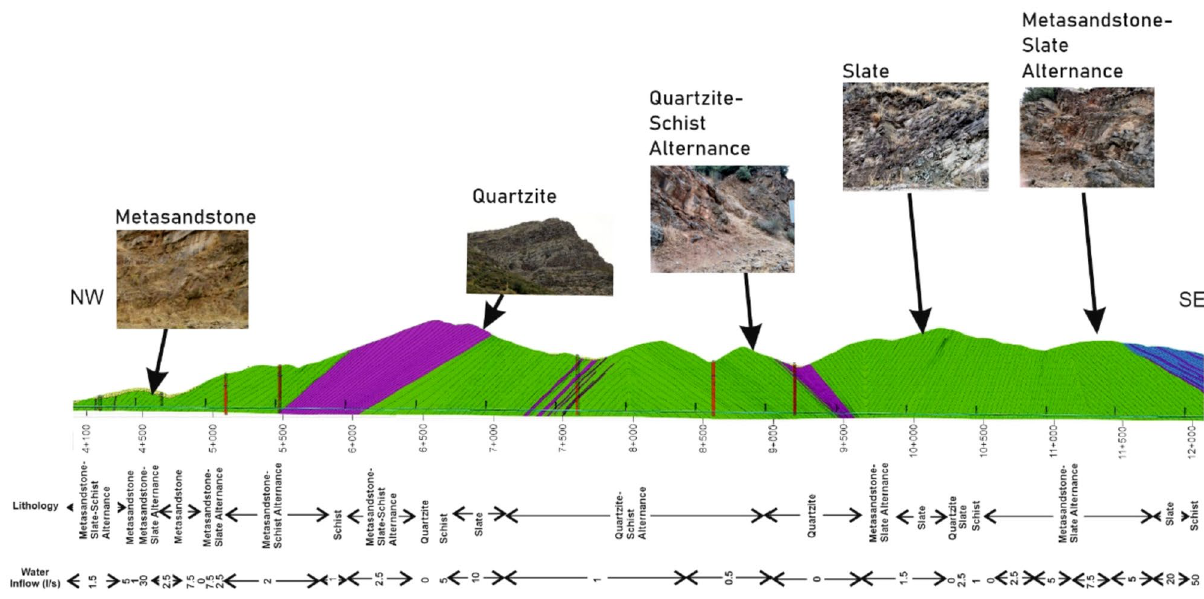
Fig. 4 Longitudinal cross section of the Bahce–Nurdag Tunnel (section includes the TBM part) (modified after Fugro Sial Inc. [18])